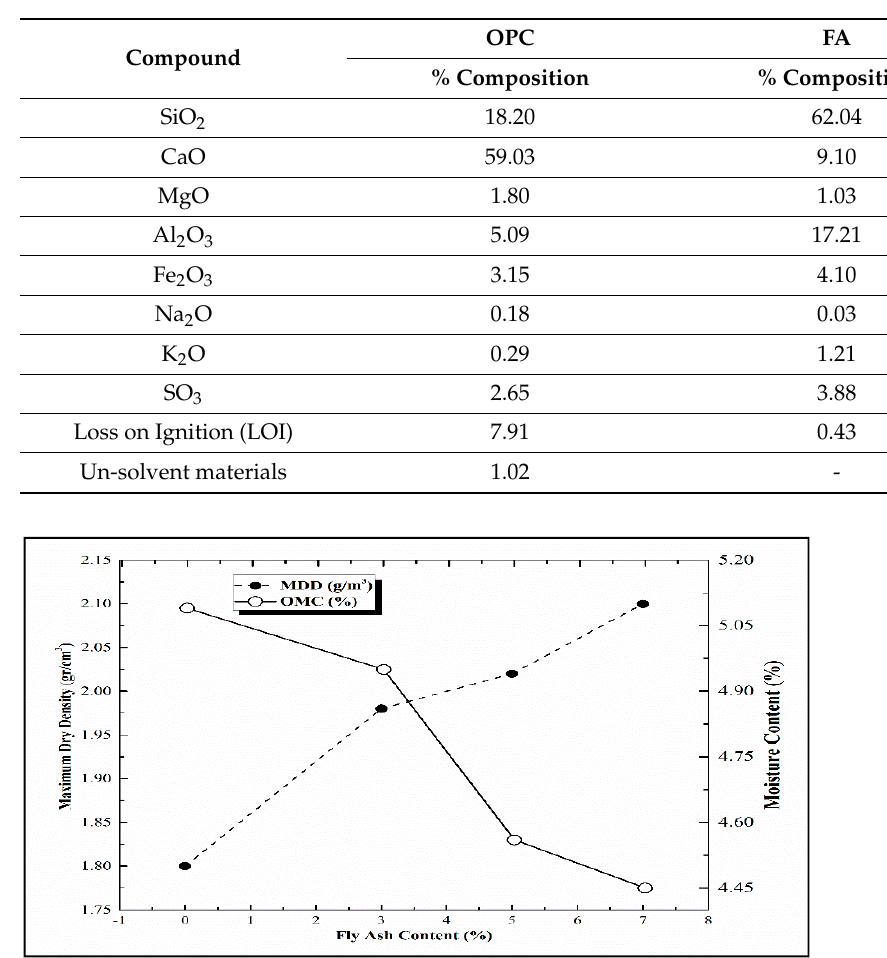
Table 3. Chemical composition of OPC and FA.